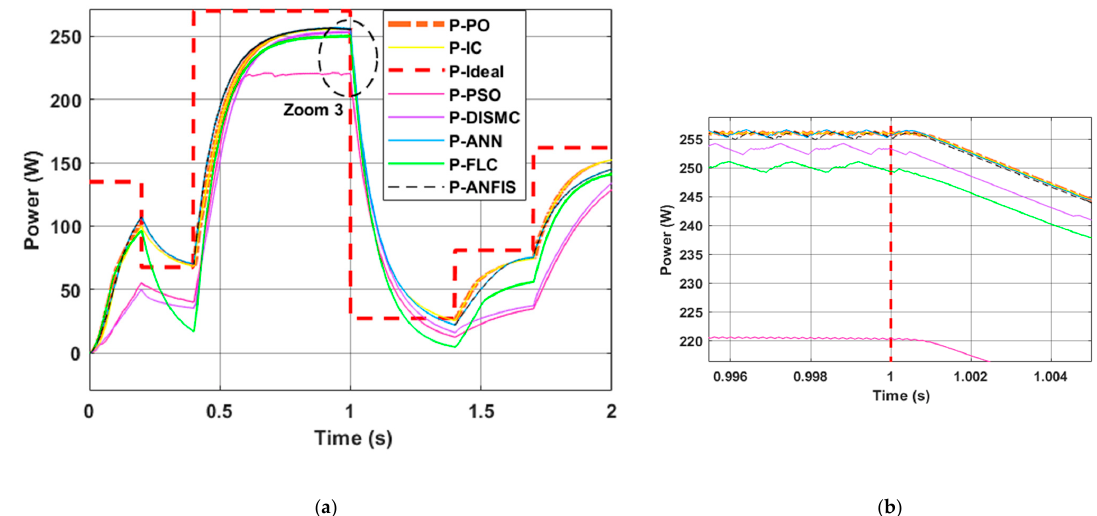
34 of 43 Figure 16. Response times (s) of MPPT algorithms under steady-state weather conditions: Test 1.